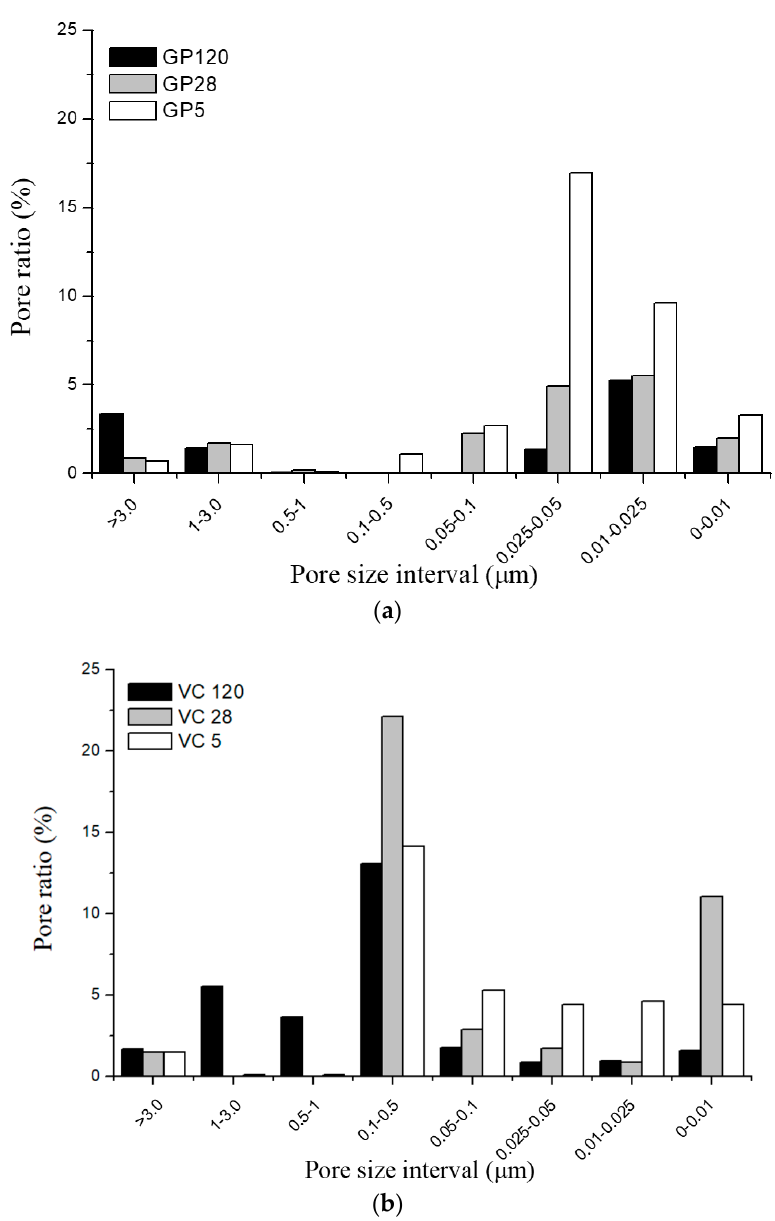
Figure 10. Pore size distribution of ( a ) GP and ( b ) VC aggregates.